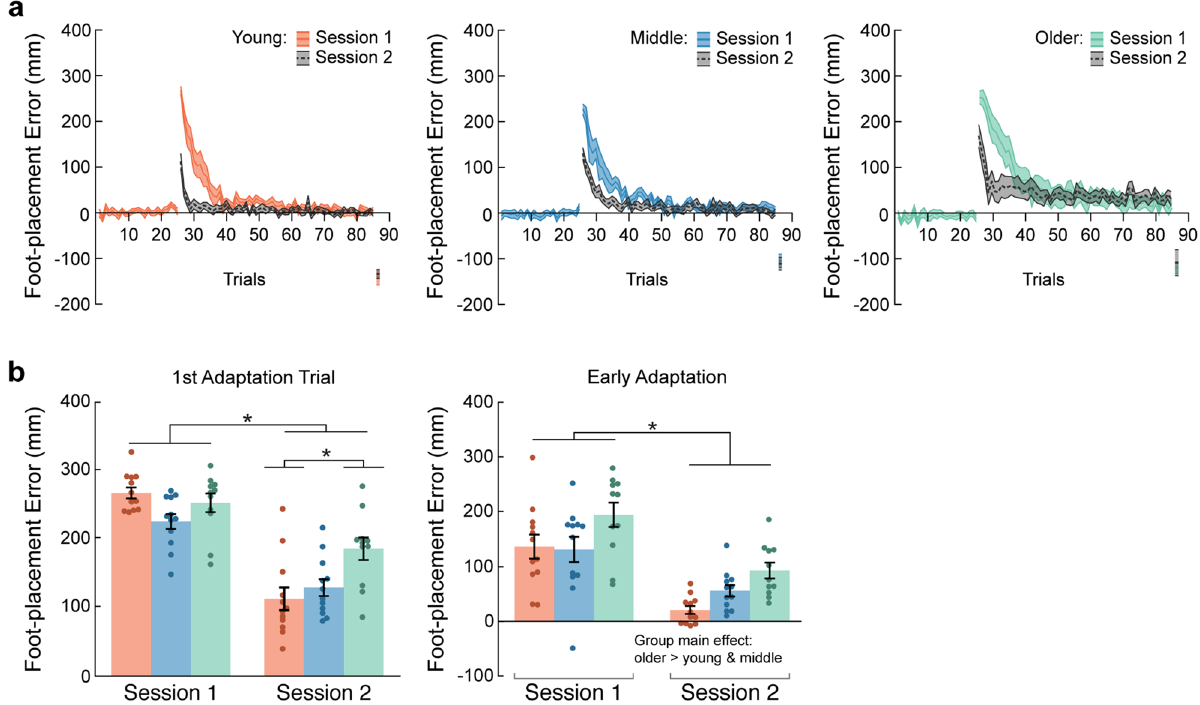
Figure 3. Aging and visuomotor retention. ( a ) Group mean ± SE foot-placement error for all trials in the baseline, adaptation, and post-adaptation phases across testing sessions. ( b ) Group mean ± SE foot-placement error for the first adaptation and early adaptation trials of the first target across testing sessions. Testing sessions occurred one week apart. *Indicate that values are significantly different from each other ( p <